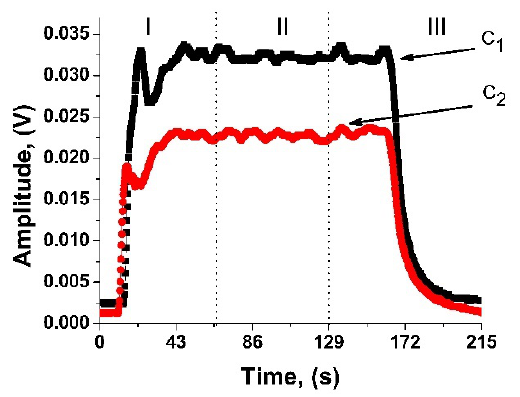
Figure 2. C 1 and C 2 Fourier coefficients obtained with the lock-in from mist for a chamber length of 150 cm.